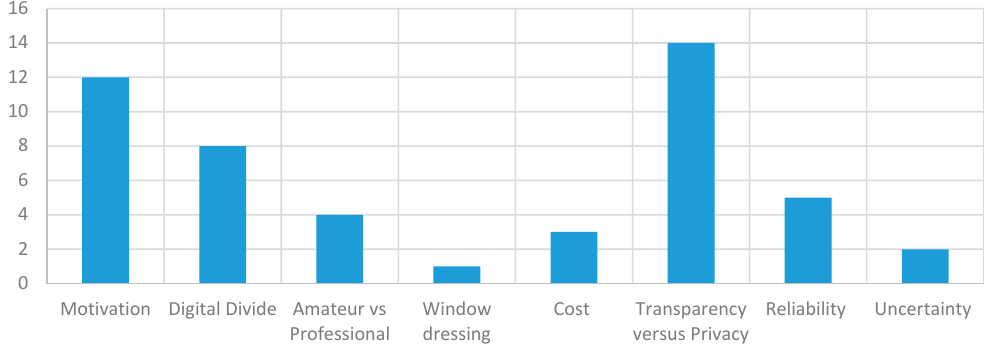
Figure 7. Distribution of existing literature according to attributes.